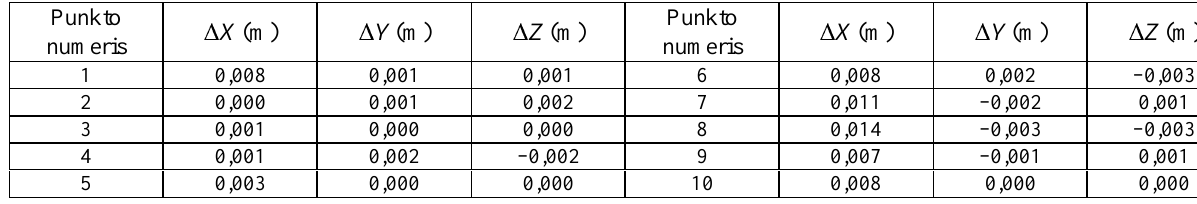
Table 2. Changes of point coordinates